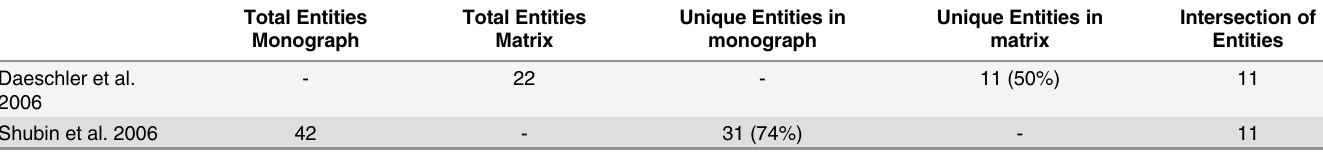
Table 5. Number of anatomical entities, unique and shared, described in monographs vs. matrices for Tiktaalik . Total Entities